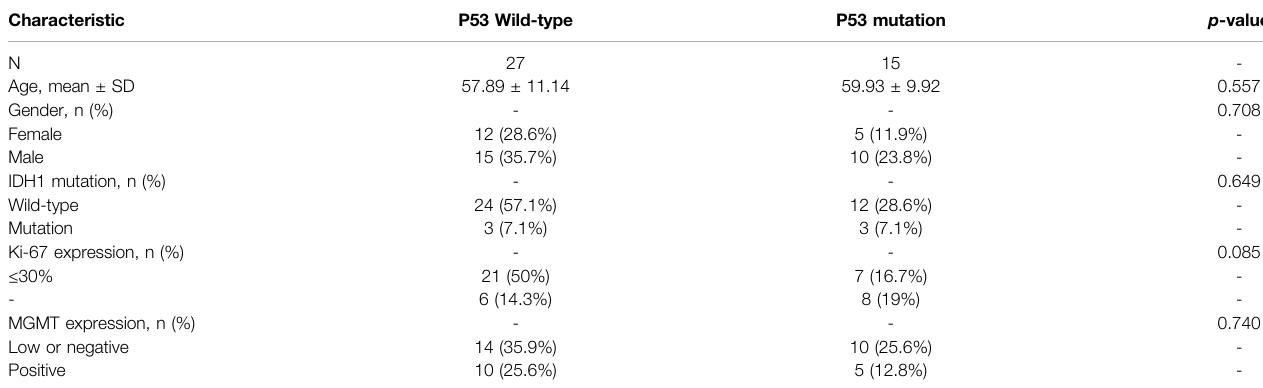
TABLE 2 | Basic characteristics of all enrolled clinical